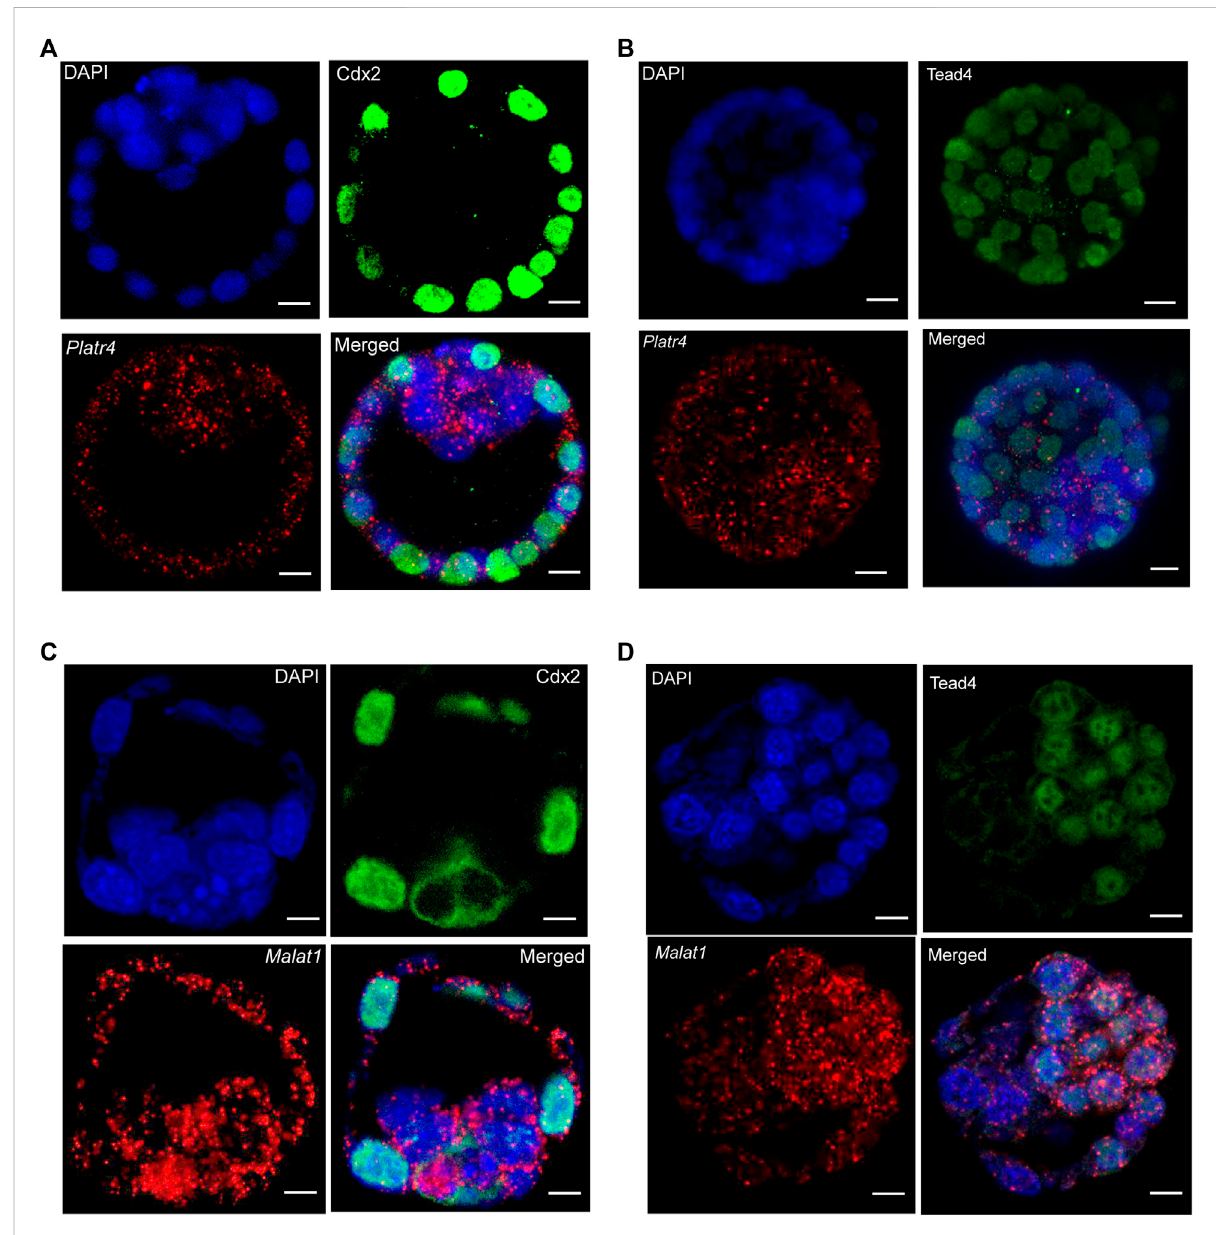
FIGURE 3 (A) CombiningIFandsmRNAFISHusinga Platr4 lncRNAprobeandanti-Cdx2antibody (B) CombiningIFandsmRNAFISHusinga Platr4